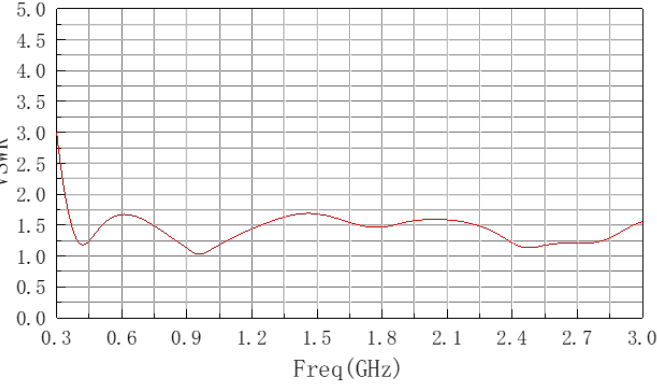
Figure 6. The optimal VSWR curve. The final structure of the antenna determined according to the final VSWR curve is shown in Figure 7. The corresponding specific structural parameters are shown in Table 1, where the cone angle θ 0 of the trapezoidal ground plane is taken as 32 ◦ .